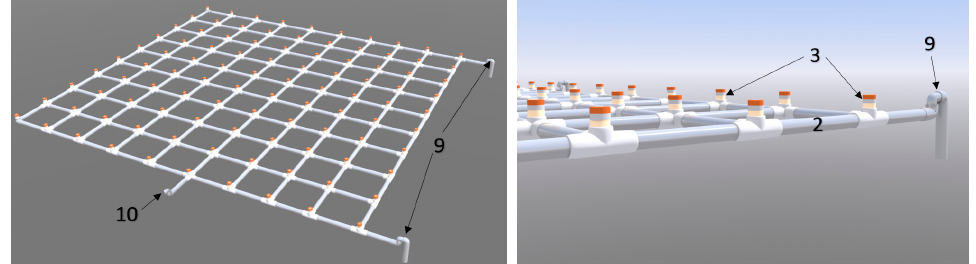
Figure 10. Details of the exit upside-down U-shaped tube for the withdrawal of extra water, and inlet for refilling it. (3) multilayer filters; (2) pipeline network; (9) exit upside-down U-shaped tube; (10) inlet.